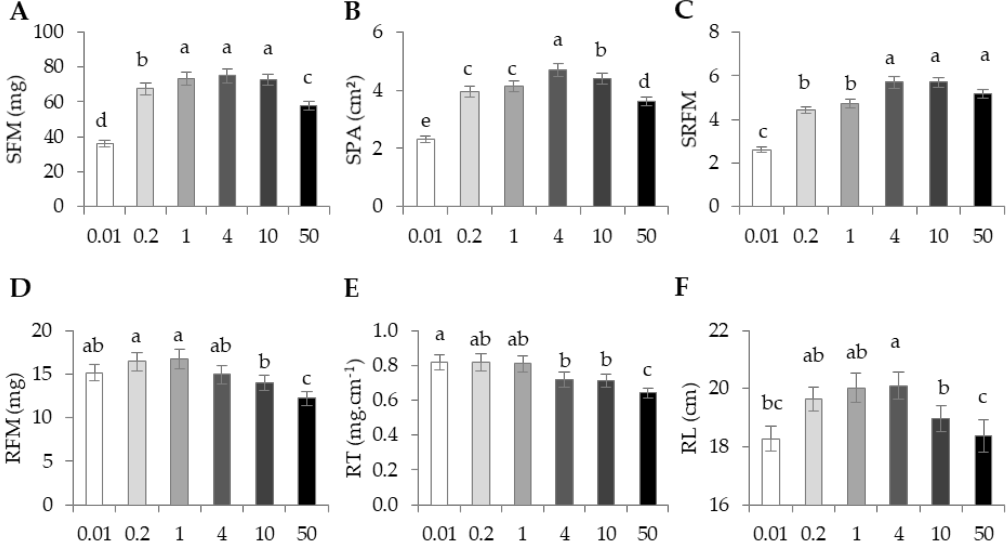
Figure 2. Average of morphological traits on the four Arabidopsis accessions grown in six different NO 3 supplies. On the x axis, nutrition regimes are reported in bars of different shades of grey, according to NO 3 concentration (mM). On the y axis, shoot fresh matter (( A )-SFM), shoot projected area (( B )-SPA), shoot-to-root fresh matter ratio (( C )-SRFM), root fresh matter (( D )-RFM), root thickness (( E )-RT) and primary root length (( F )-RL) are reported. Different letters indicate values that are significantly different at p < 0.05.